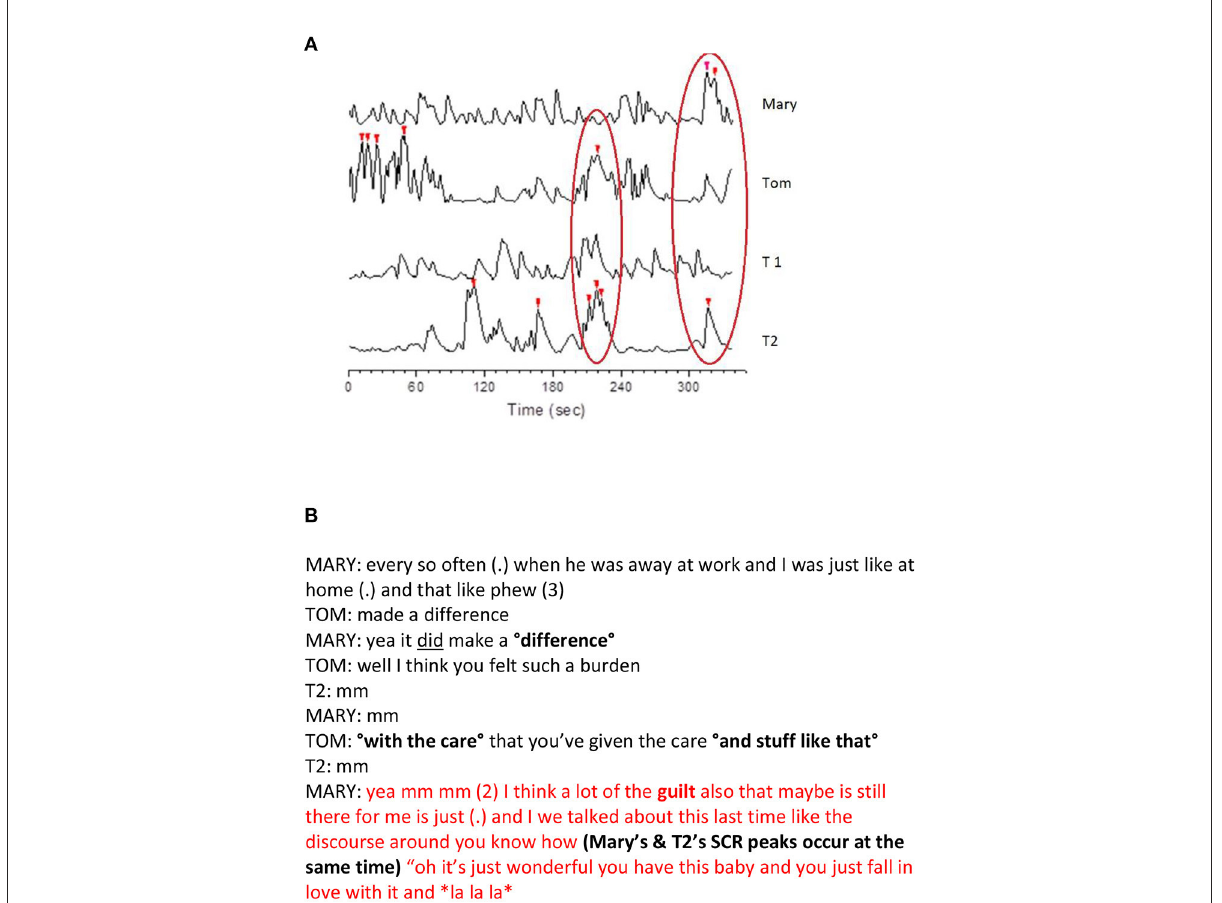
FIGURE2 Visualization of the embodied recordings and a transcript of the dialogue during the SCR peaks. (A) The synchronization of the participants’ SCR peaks during a short segment of dialogue. The peaks marked with red triangles are the SCRs that were > 2 SD of the participant’s mean. The left red oval depicts synchrony between Tom and therapist 2 and the right oval depicts synchrony between Mary and therapist 2. (B) The dialogue occurring at the moment of Mary’s and therapist 2’s highest SCR peaks (right red oval in A ). Both panels present a microanalytic study on moments in couple therapy during which there were several SCR peaks between participants. The embodied variables were used together with the transcript of the moment. T1, therapist 1; T2, therapist 2.